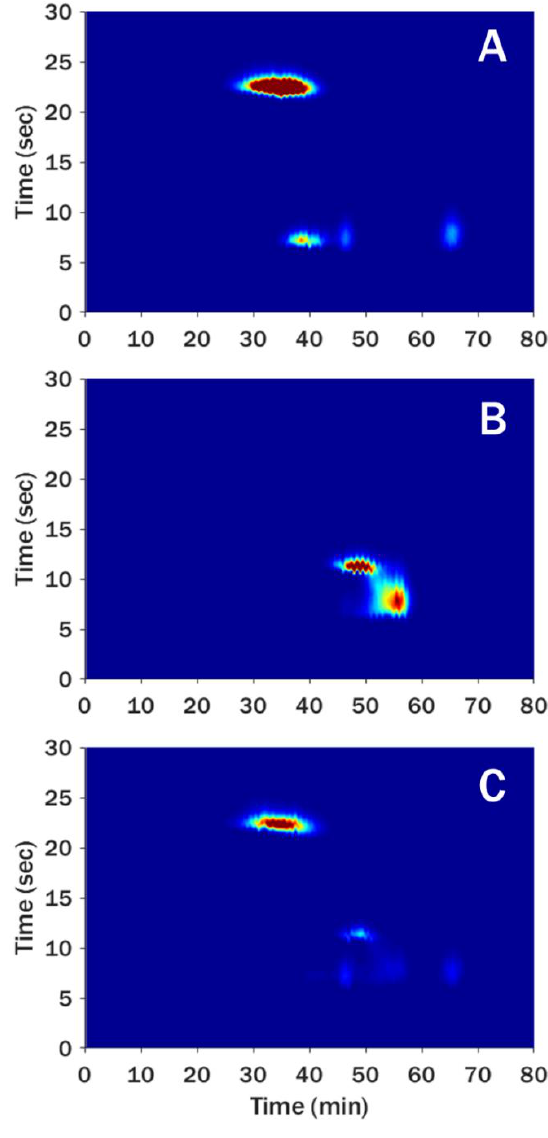
Figure 7. aq-SEC×RPLC analysis of ( A ) PAA, ( B ) MD, and ( C ) HY. 20 µL of 20 mg/mL injection Figure 7. aq-SEC × RPLC analysis of ( A ) PAA, ( B ) MD, and ( C ) HY. 20 µ L of 20 mg / mL